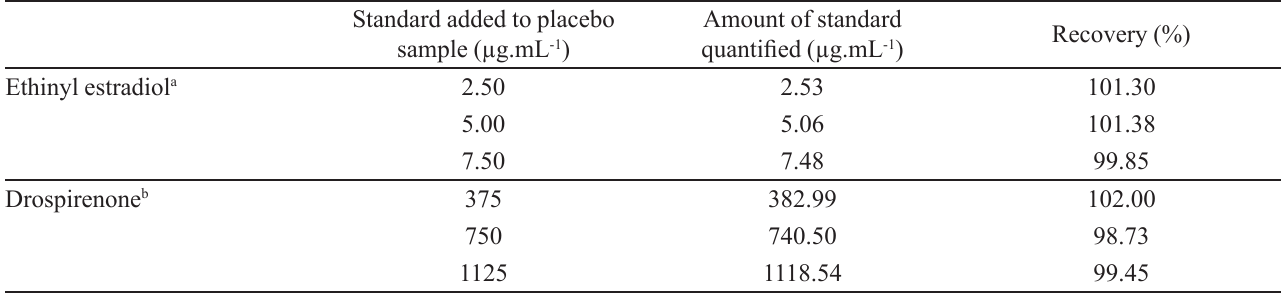
TABLE IV - Recovery of standard ethinyl estradiol and drospirenone solution added to placebo and analyzed by the proposed HPLC method